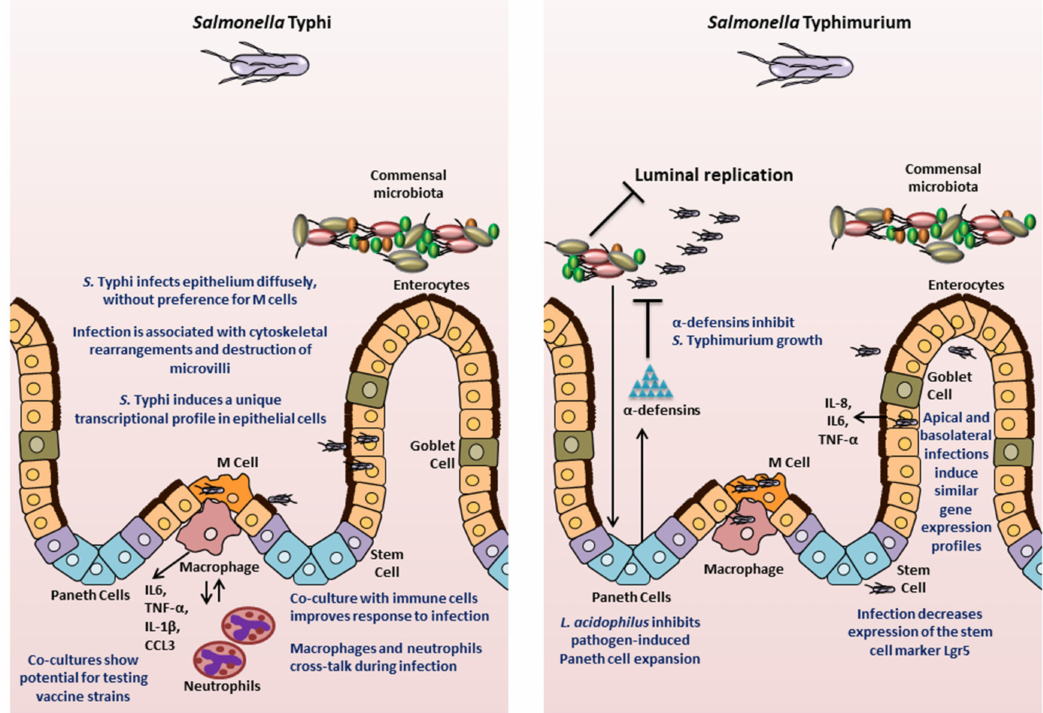
Figure 3. Insights into Salmonella pathogenesis from intestinal organoids / enteroids. The key findings for S. Typhi and S. Typhimurium are